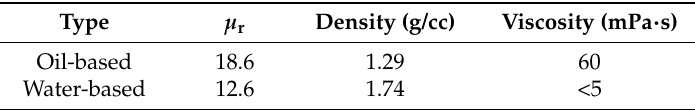
Table 2. Properties of two types of FF used in experiments.